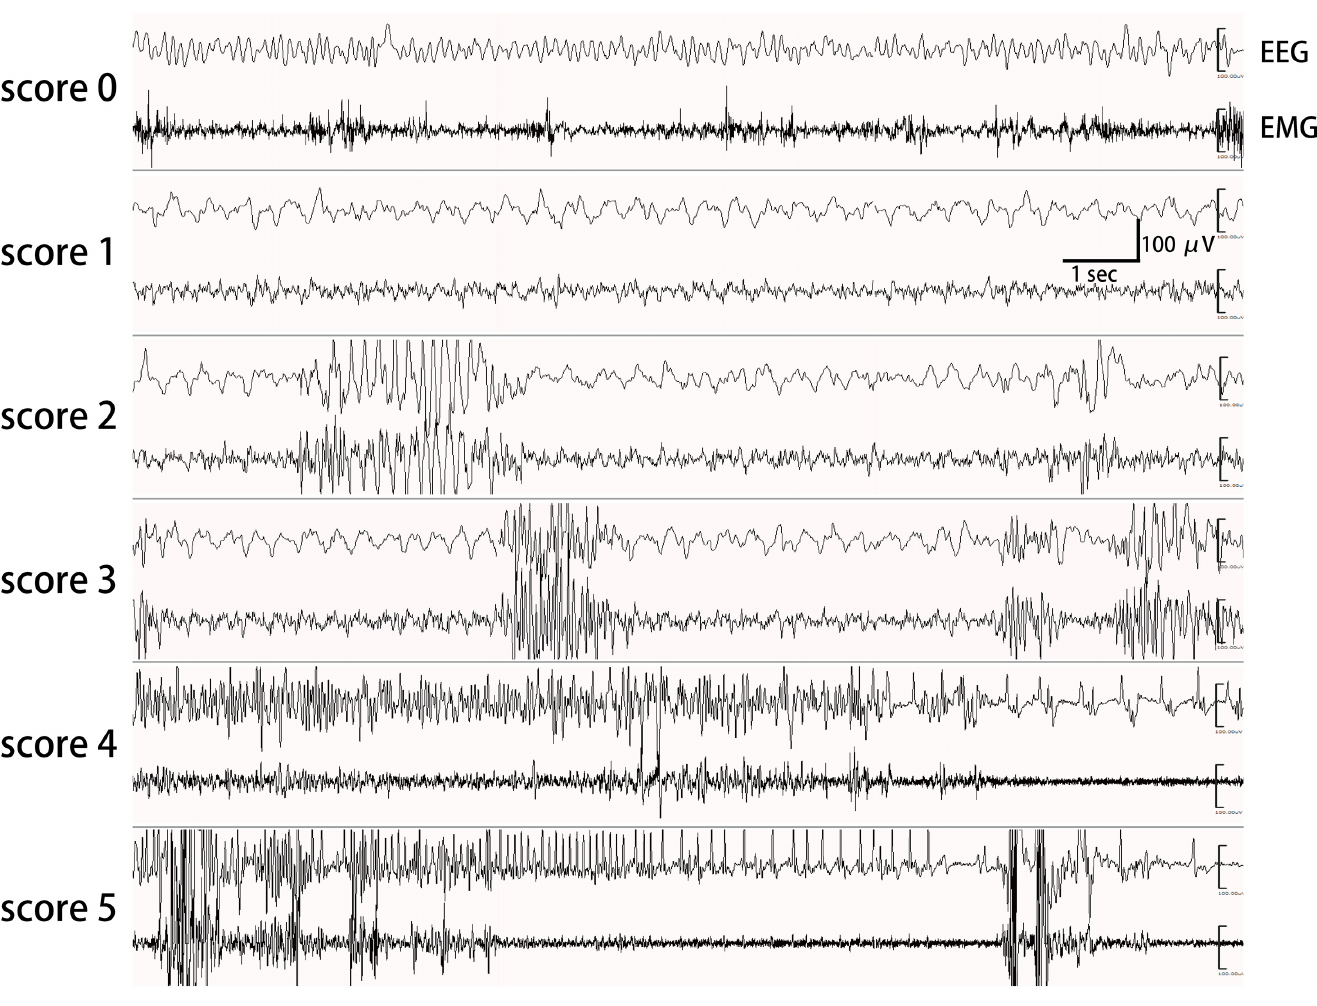
Fig 2. Representative electroencephalograms at each score of Modified Racine ’ s scale. Electroencephalogram (EEG) and electromyogram (EMG) were obtained as described in Method. Each panel shows a representative EEG recording at Score 0 to 5 of a Modified Racine ’ s scale [19]. Spikes and sharp waves were considered part of seizure activities only when they were associated with abnormal behaviors which were confirmed on video monitoring and electromyogram. A spike burst is defined as a cluster of high-amplitude and high frequency spikes, each of which lasts a few seconds to several minutes on EEG during kainic acid challenge tests